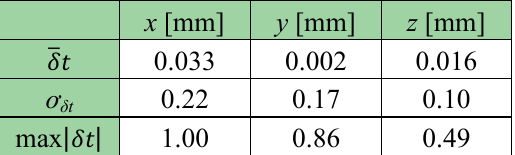
Table 3. Statistics of differences between two repeated